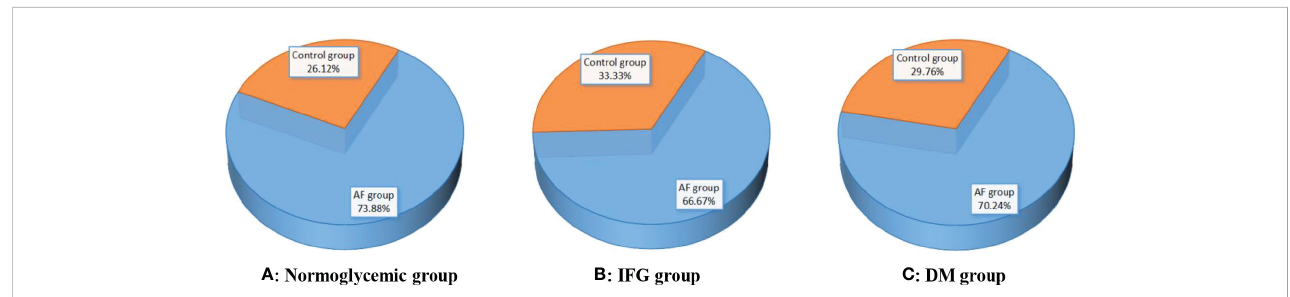
FIGURE 2 Comparison of the rate of hyperuricemia between the AF group and the control group under different FBG patterns. (A – C) Compared with controls, the rate of hyperuricemia in the AF group was signi fi cantly higher than those in the control group (all p < 0.001). AF, atrial fi brillation; IFG, impaired fasting glucose; DM, diabetes